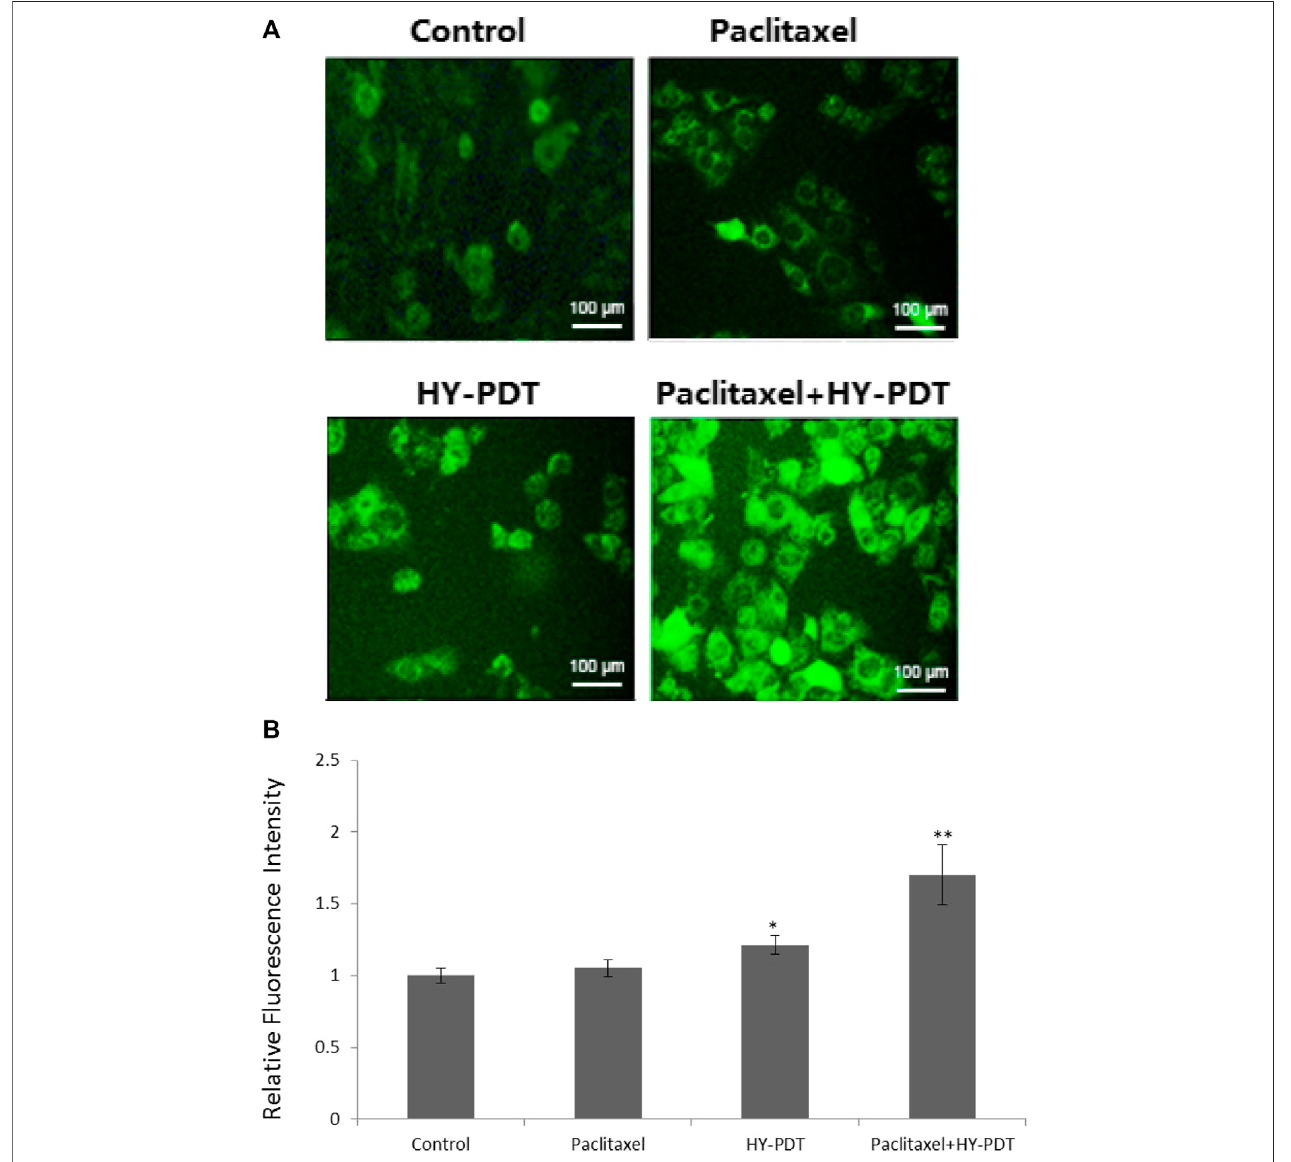
FIGURE3| MitochondrialmembranepotentialdetectioninB16-F10cells. (A) FluorescencemicroscopedetectionofB16-F10cellstreatedwithpaclitaxel(1 μ g/ml) and HY-PDT (1 μ g/ml) alone or in combination (0.5 μ g/ml each). Scale bars: 100 μ m. (B) ImageJ analysis of relative intensity. * p < 0.05, ** p < 0.01, compared to the